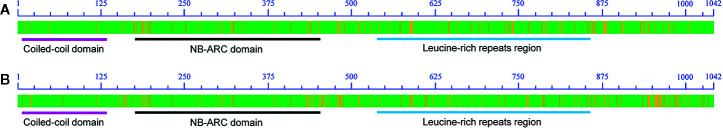
Alignment of the conserved motifs of the RppM candidate genes. (A, B) Diagrams of amino acid sequence alignments of Zm00001d023265 (A) and Zm00001d023267 (B). Matching sequence regions are indicated in green, and variable regions are shown in yellow. Coiled-coil, NB-ARC and leucine-rich-repeat domain regions are underlined with violet, black and blue, respectively.